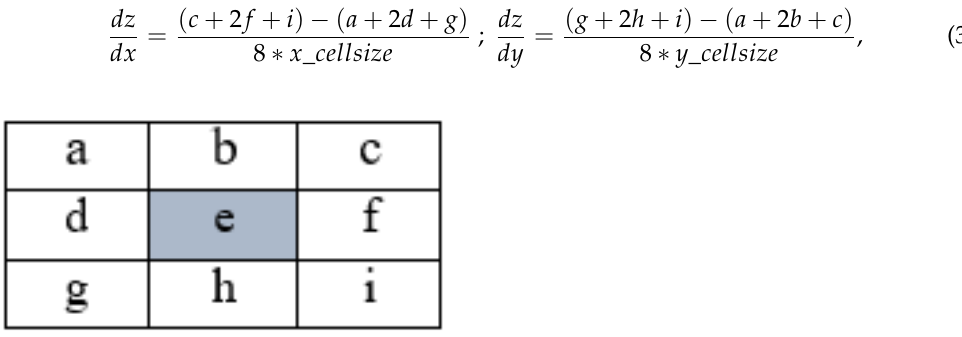
Figure 9. Moving 3 × 3-pixel window to calculate the surface slope.